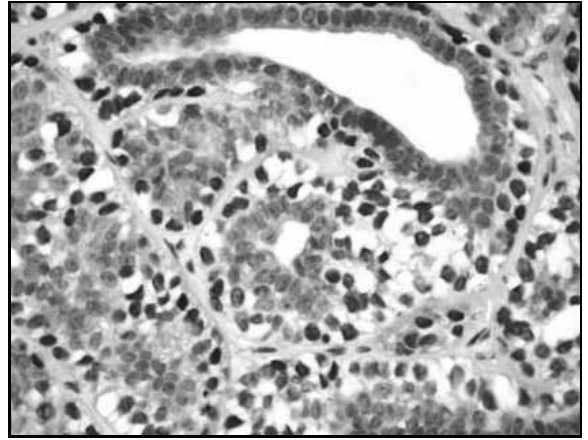
Figure 4 – Positive reaction to the KI 67 cell proliferation marker (IHQ 400×) IHQ: